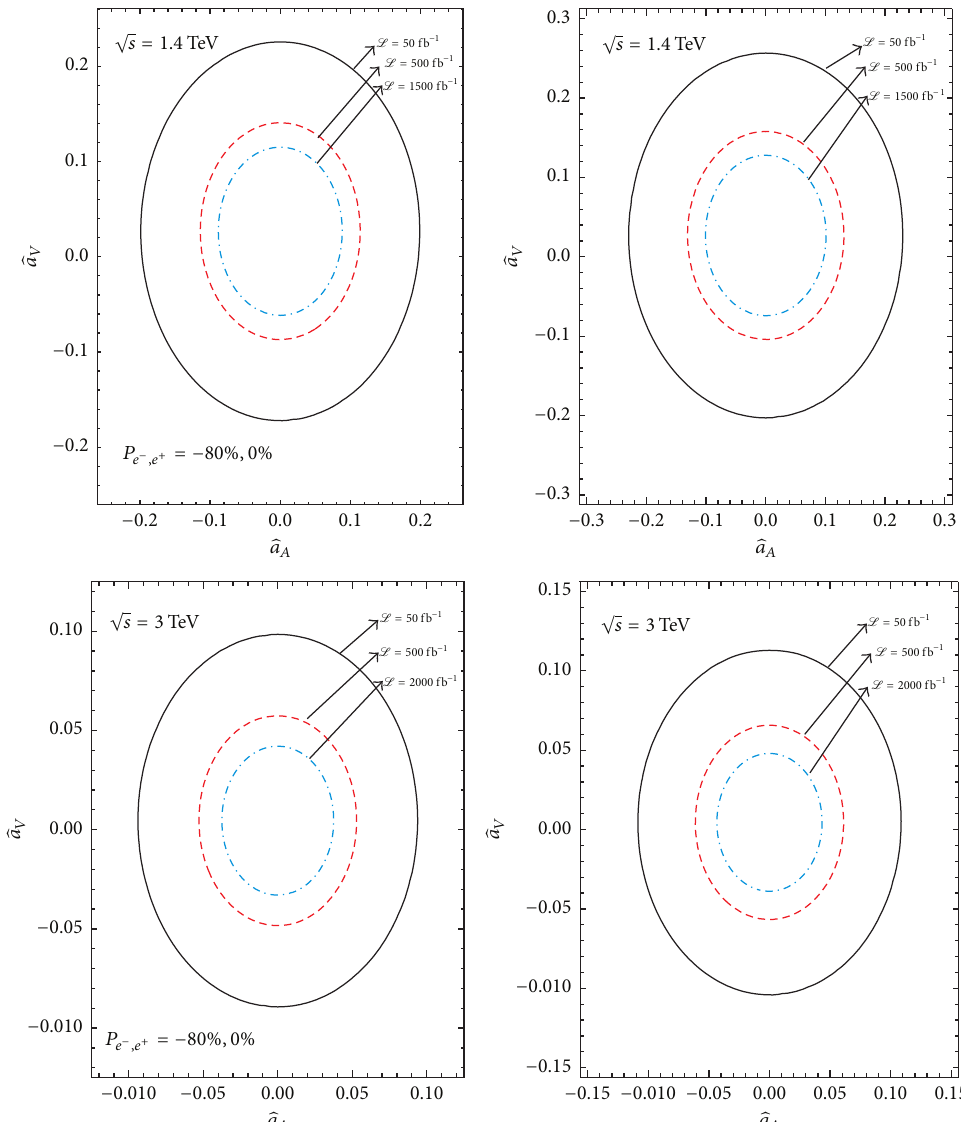
Figure 4: Limits contours at the 95 % C . L . in the ̂𝑎 𝑉 −̂𝑎 𝐴 plane for 𝛾𝑒 − → 𝑡𝑏 ] 𝑒 ( 𝛾 is the Compton backscattering photon) and √𝑠 = 1.4, 3 TeV with polarized and unpolarized